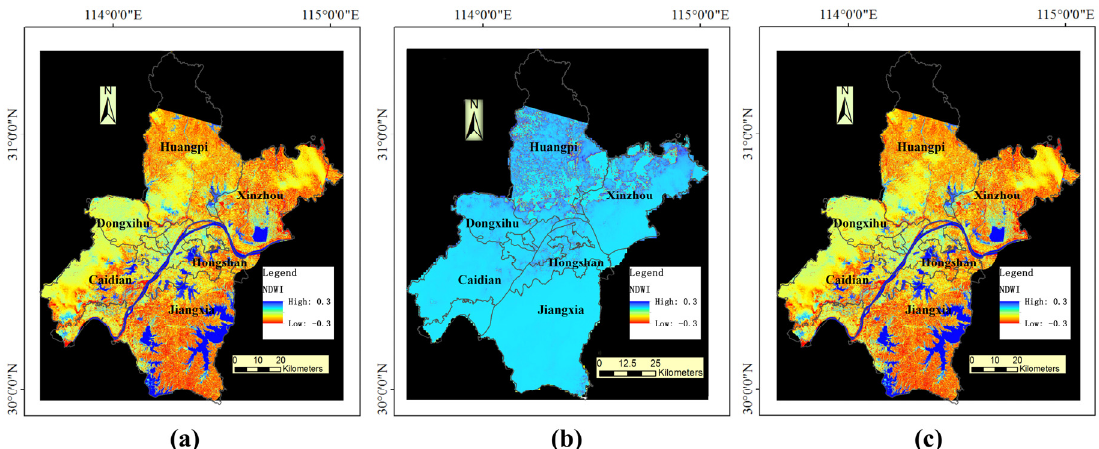
Figure 7. Terra/MODIS waterlog NDWI distributions in Wuhan city during periods of torrential rainfall: 30 March 2015 ( a ), 2 April 2015 ( b ) and 7 April 2015 ( c ). Normalized Difference Water Index.